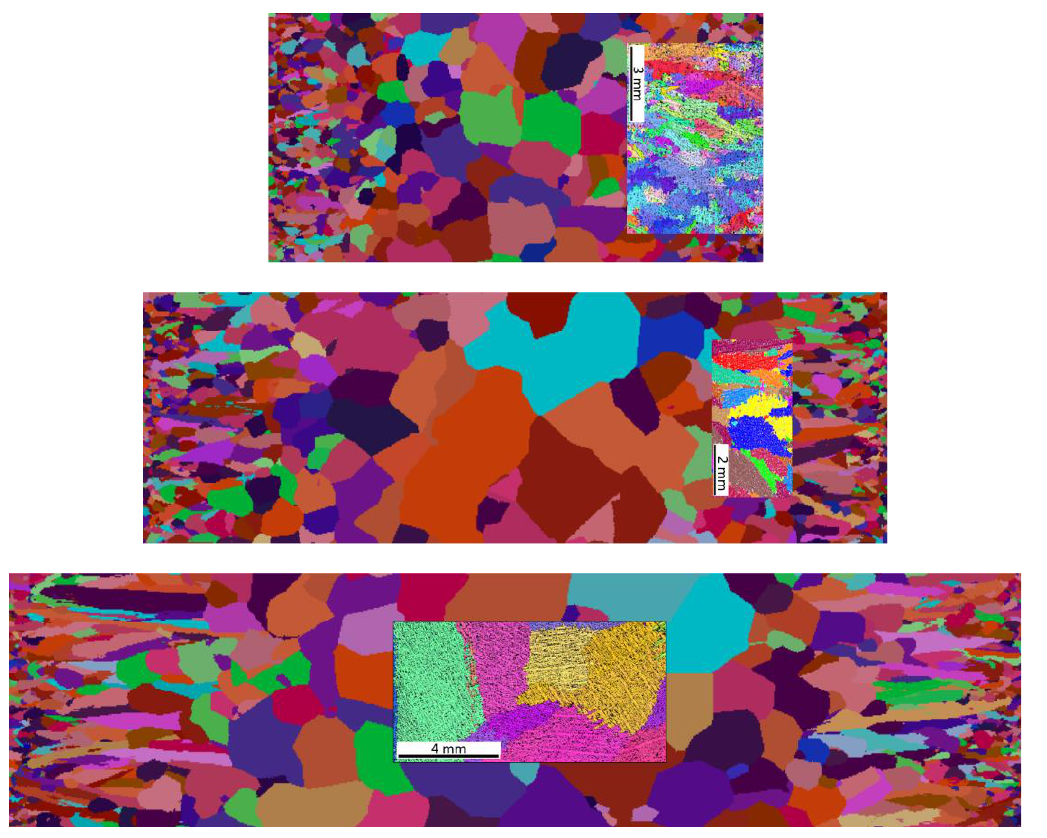
Figure 11. Superimposed images from a cellular automaton simulation with actual EBSD images of the structure.